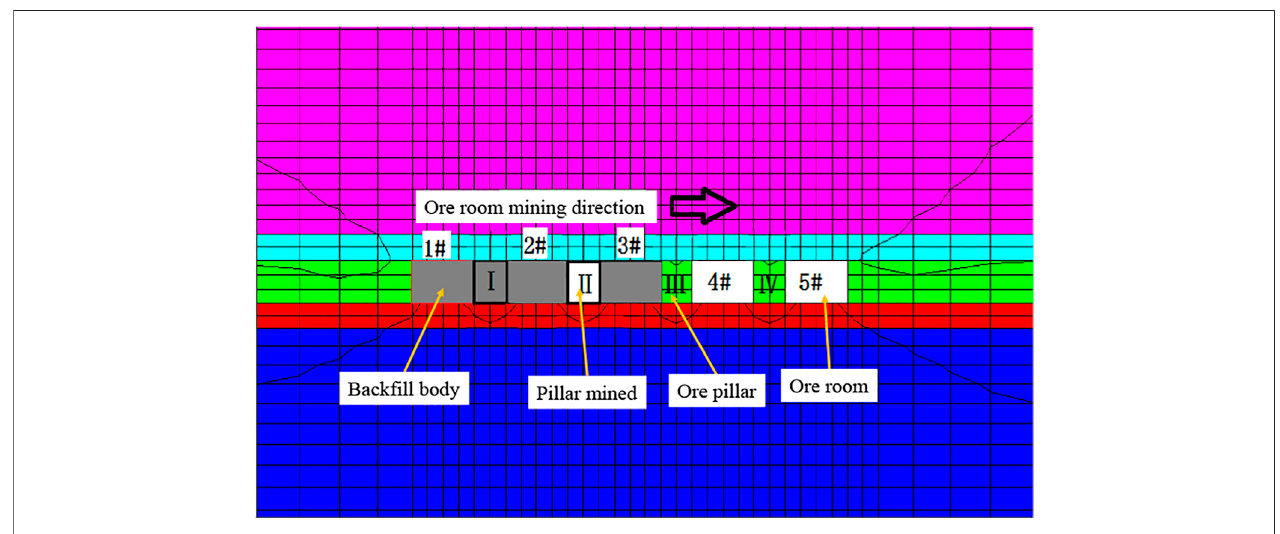
FIGURE 4 | Mining and back fi ll schematic of rooms and pillars.